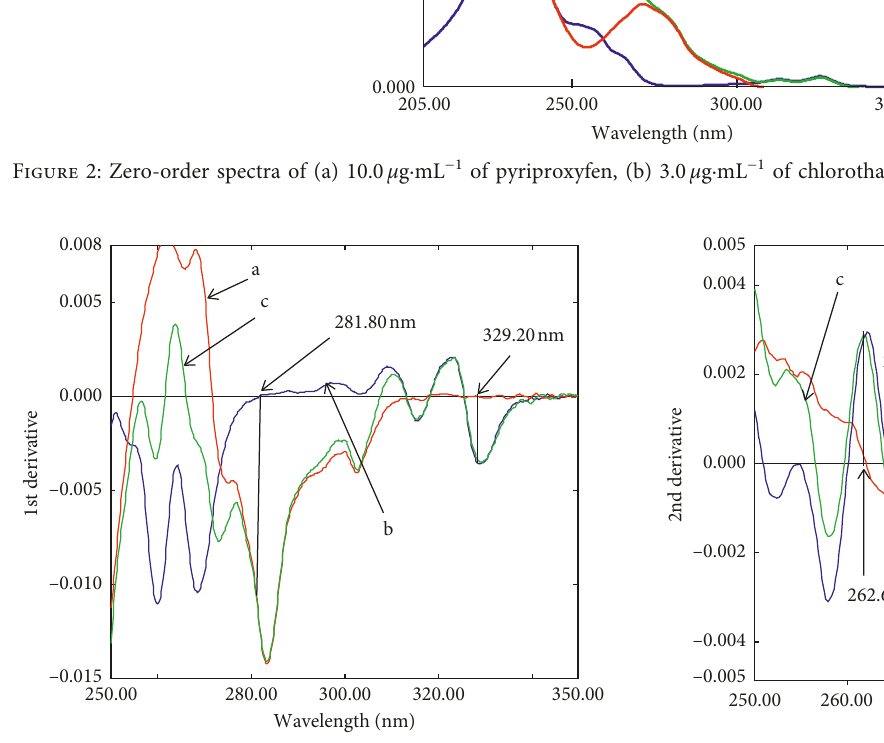
Figure 4: Second-order derivative spectra of (a) 10.0 μ g · mL − 1 of pyriproxyfen, (b) 3.0 μ g · mL − 1 of chlorothalonil, and (c) their mixture in